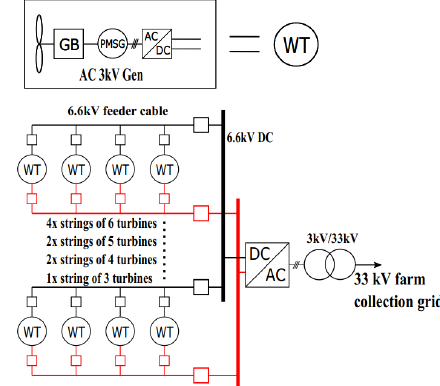
Figure 7. DC radial